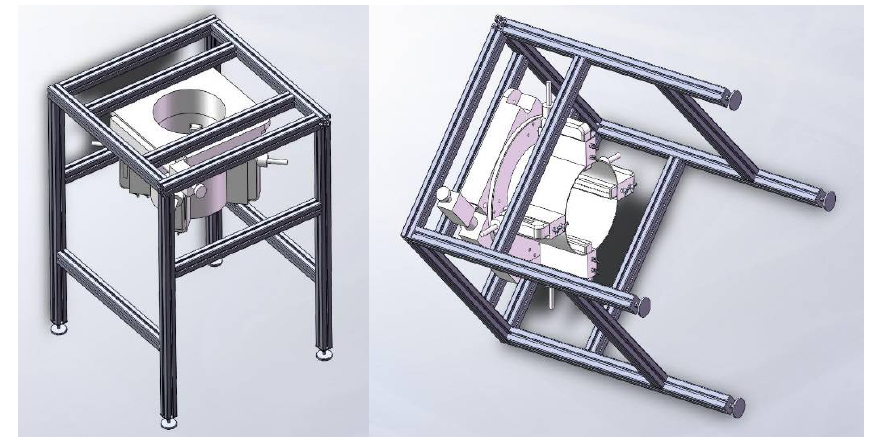
Figure 5. Experimental setup for the 3D ultrasound imaging ring system.